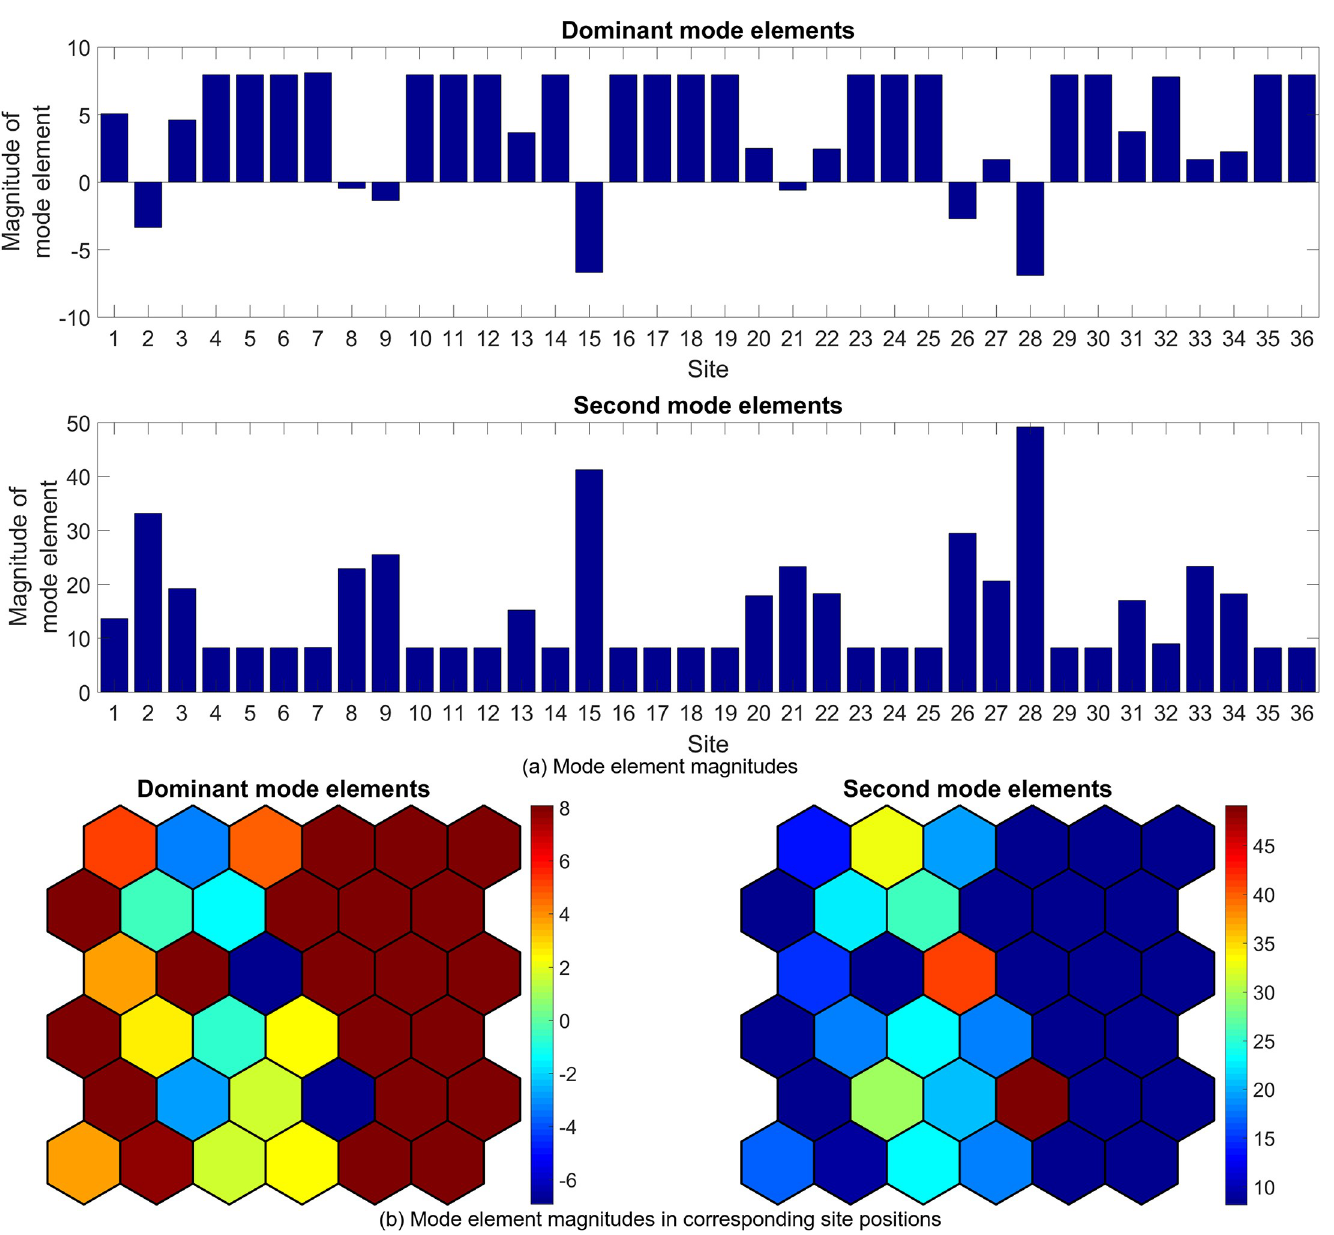
Fig 23. Example mode elements of the dominant and second modes from a single simulation for maximum site fuel value of 25 units, shown in bar graph form (a) and in the spatial positions of the corresponding sites (b). The dominant mode values approximate the mean site fuel values, while the second mode values show the degree to which site fuel values oscillate and/or undergo long-term